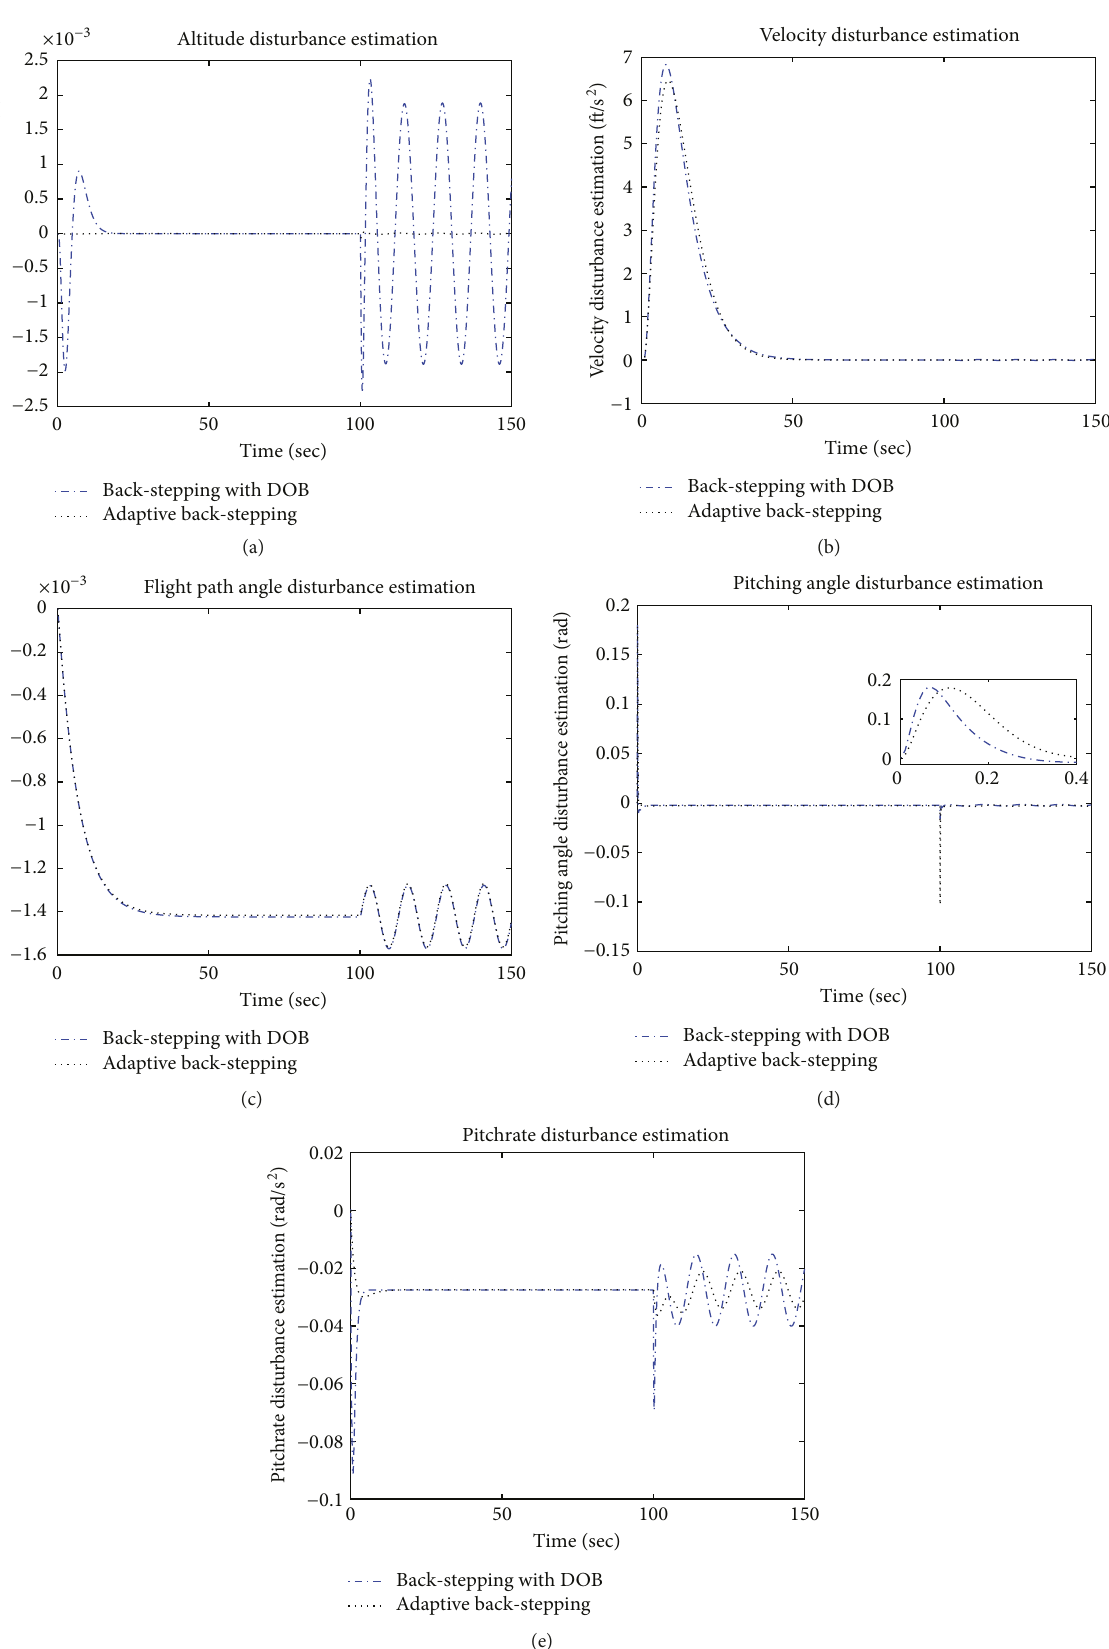
Figure 6: Lumped disturbance estimated by